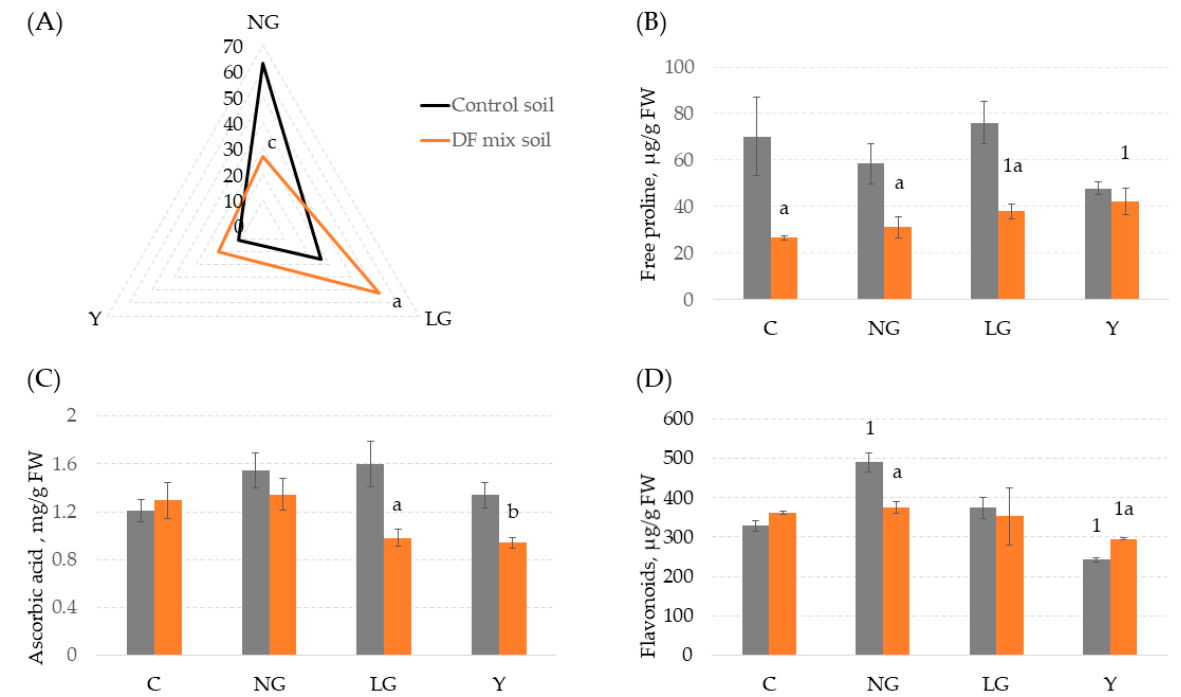
Figure 4. Distribution of phenotypic groups ( A ) and content of free proline ( B ), ascorbic acid ( C ), and flavonoids ( D ) in Co-pretreated V. faba plants after one month of exposure to the mildly polluted soil mix. Phenotypes of morphoses: NG—normal green, LG—light green, Y—yellow; C—plants grown in control soil; DF—plants from soil collected from different sites of the drill factory. Significance level: a p < 0.05, b p < 0.01, c p < 0.001 compared with the respective phenotypic group from control soil; 1 p < 0.05, compared with Co-untreated plants grown in the same soil